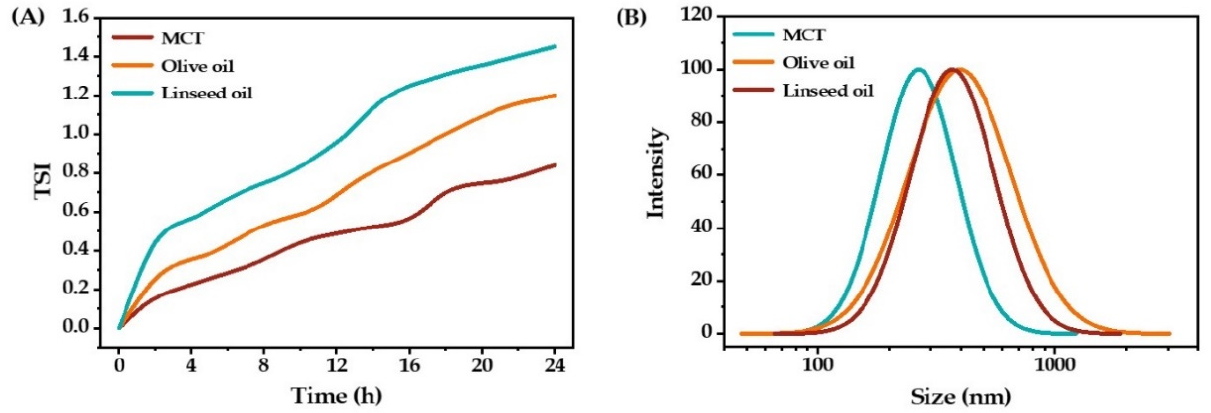
Figure 3. The stability ( A ) and droplet size distribution ( B ) of O/W emulsions with different oil types.